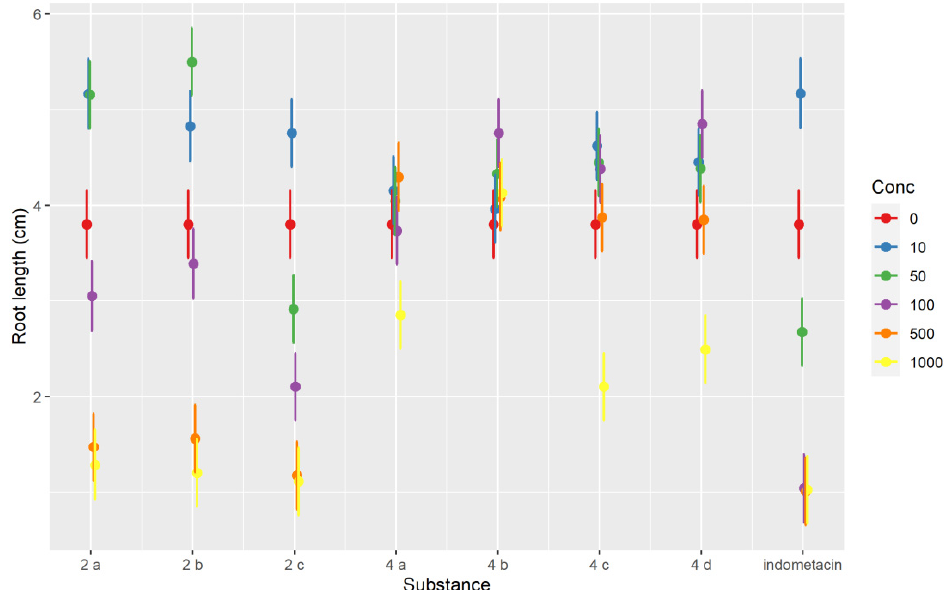
Figure 4. Interaction plot showing the interaction effects between the tested compounds and the concentration for the Triticum phytotoxicity test.